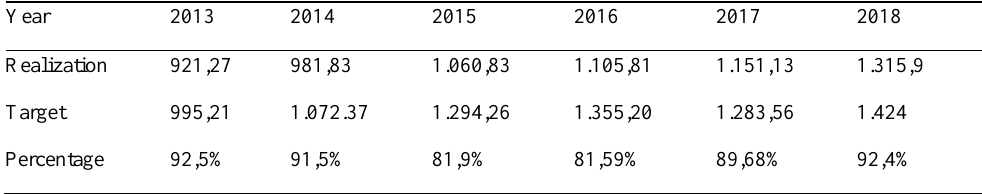
Table 1: Indonesian Tax Revenue Target and Realization 2013 – 2018(in Billion